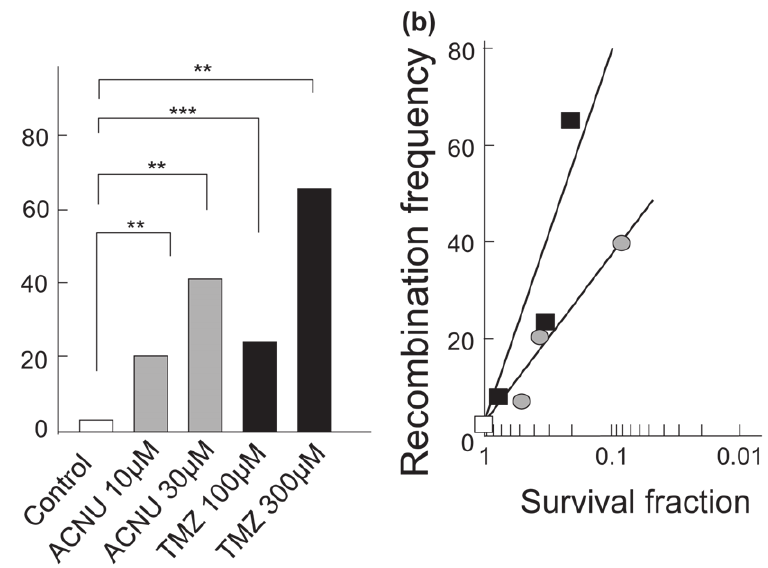
Figure 4. Homologous recombination in SPD8 cells. a , the reversion frequency from a non-functional to a functional hprt gene, giving resistance to HaST following a 24 h treatment with ACNU (10 m M and 30 m M, striped columns) or TMZ (100 m M and 300 m M, closed columns) is shown. Control, open column. Two asterisks (**), P , 0.01; three asterisks (***), P , 0.001. b , recombination frequency against the surviving fraction of cells following a 24 h treatment with ACNU (10 m M and 30 m M, striped circles) or TMZ (100 m M and 300 m M, closed squares). Control, open